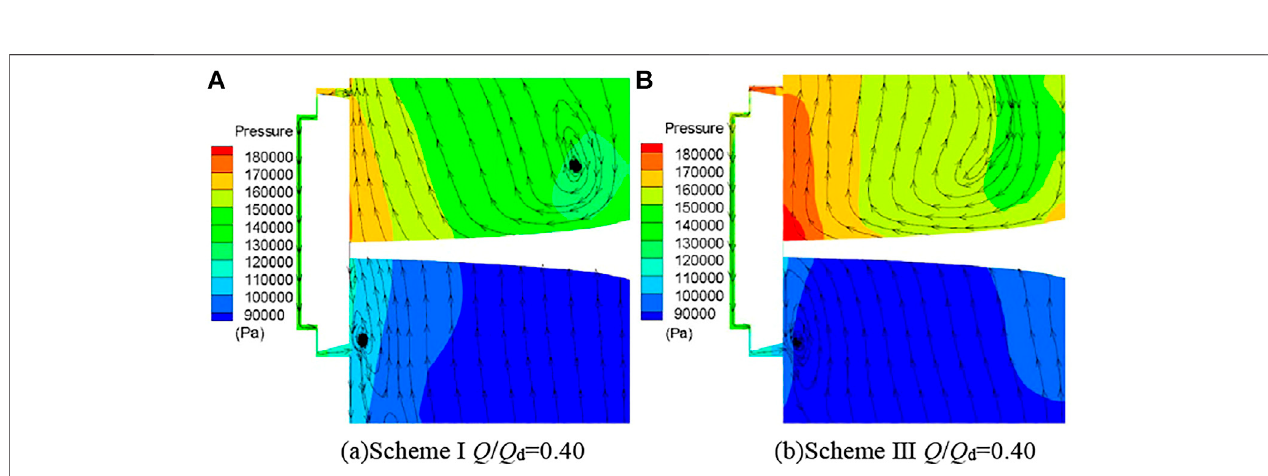
FIGURE 9 | Characteristics of internal fl ow in the gap of the full-tubular pump. (A) Scheme Ⅰ Q / Q d = 0.40 (B) Scheme Ⅲ Q / Q d = 0.40.